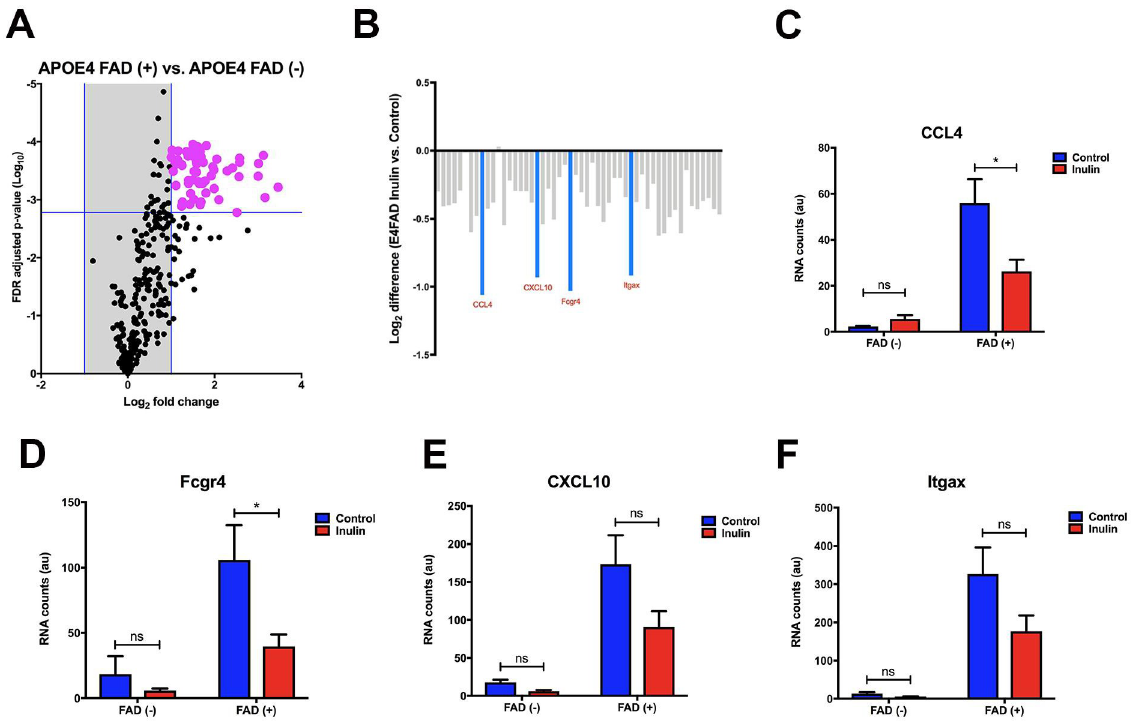
Fig 7. Analysis of inulin-induced changes in inflammatory gene expression in the hippocampus. (A) In APOE4 mice with and without the FAD mutations, data are plotted as the mean expression ratios with their respective FDR-adjusted p -value. This revealed 52 genes that were significantly differentially enriched (magenta) with log 2 (fold change) greater than one due to the FAD mutations. (B) The 52 genes that were enriched due to the FAD mutations were further examined in the context of diet manipulation. Overall, there was a trend for most of the 52 genes to be downregulated due to the prebiotic inulin in E4 FAD mice (e.g., gray bars). Furthermore, an approximately 2-fold decrease in expression was observed in 4 genes (aquamarine). Among these, (C) CCL4 , and (D) Fcgr4 were significantly decreased. Although there was a strong visual trend for both (E) CXCL10 and (F) Itgax to be decreased due to the prebiotic inulin, these decreases were not statistically significant. Data are mean ± SEM, n.s. = not significant; � p < 0.05.